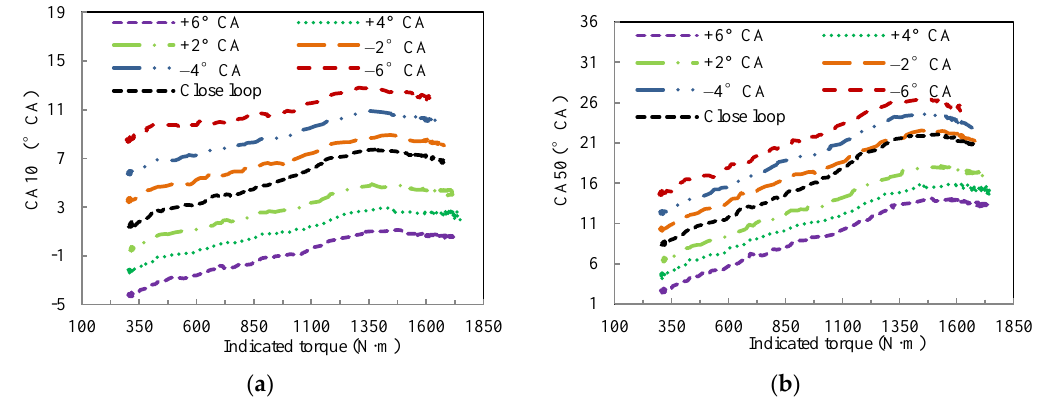
Figure 15. Effect of FSIT strategies on combustion performance: ( a ) CA10; ( b ) CA50. Figure 15. E ff ect of FSIT strategies on combustion performance: ( a ) CA10; ( b ) CA50.